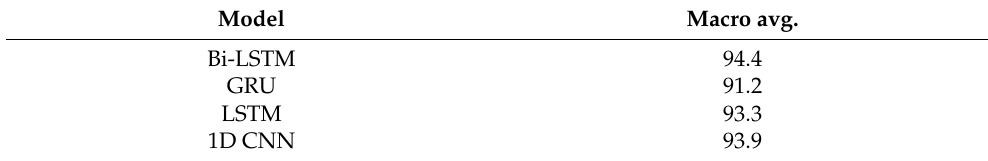
Table 5. The average micro-averaged gait classification accuracy was computed for each horse using cross-validation, where the horse was left out for evaluation. The cross-validation was repeated five times for each model, and the results were averaged.